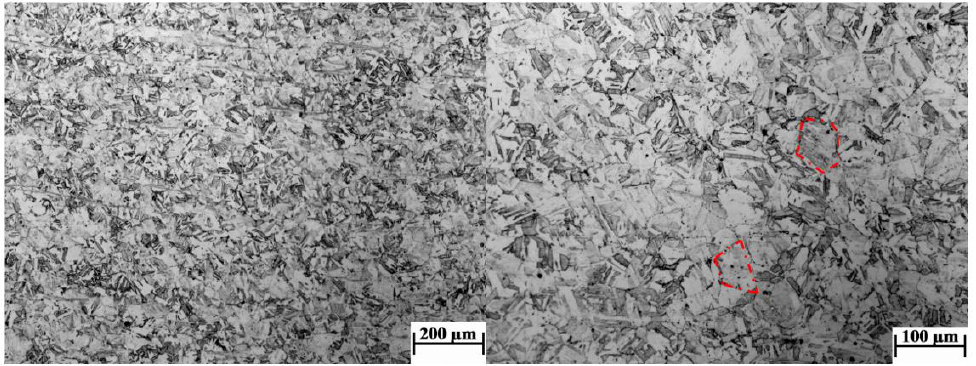
Figure 7. Grain size of twice heating process.